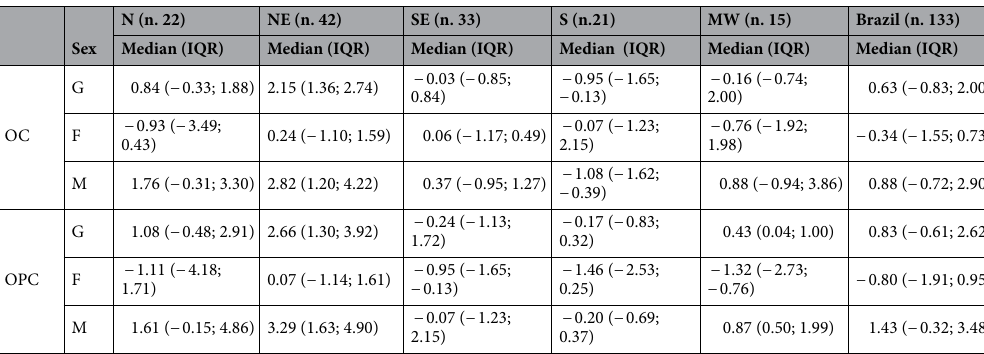
Table 1. Annual percent change of oral and oropharyngeal cancer mortality: median and interquartile range (IQR) in Brazilian intermediate geographic regions, by sex, and macro-region. Brazil, 1996–2018. OC oral cancer, OPC oropharyngeal cancer, G general, F female, M male, N North, NE Northeast, SE Southeast, MW